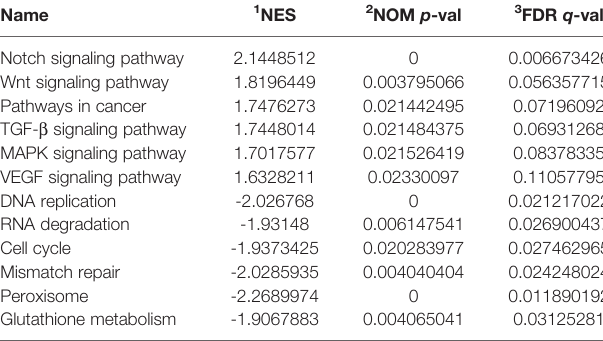
TABLE 3 | Display of GSEA enrichment results in high and low risk